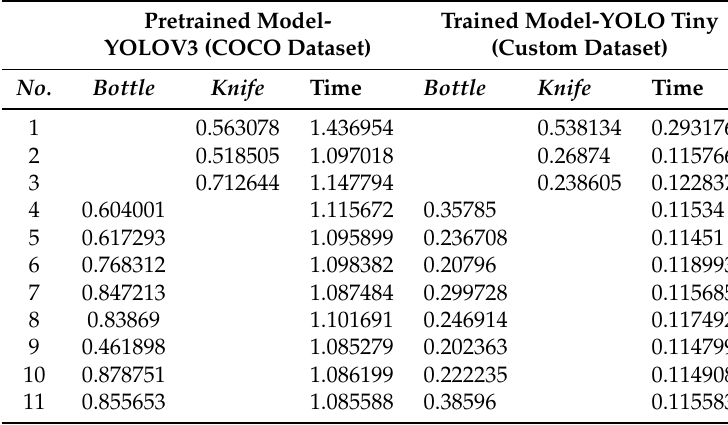
Table 1. Model accuracy and speed comparison experiment